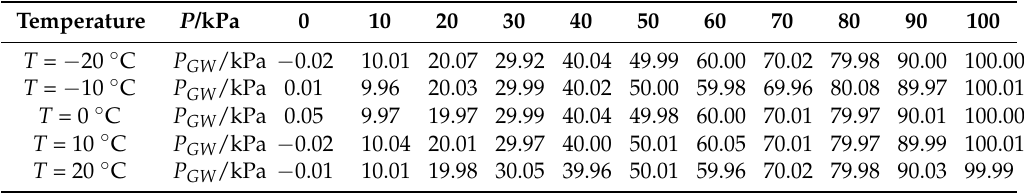
Table 4. The predicted output P GW of array-type pressure sensor though GA-WNN algorithm within the hybrid composite range.